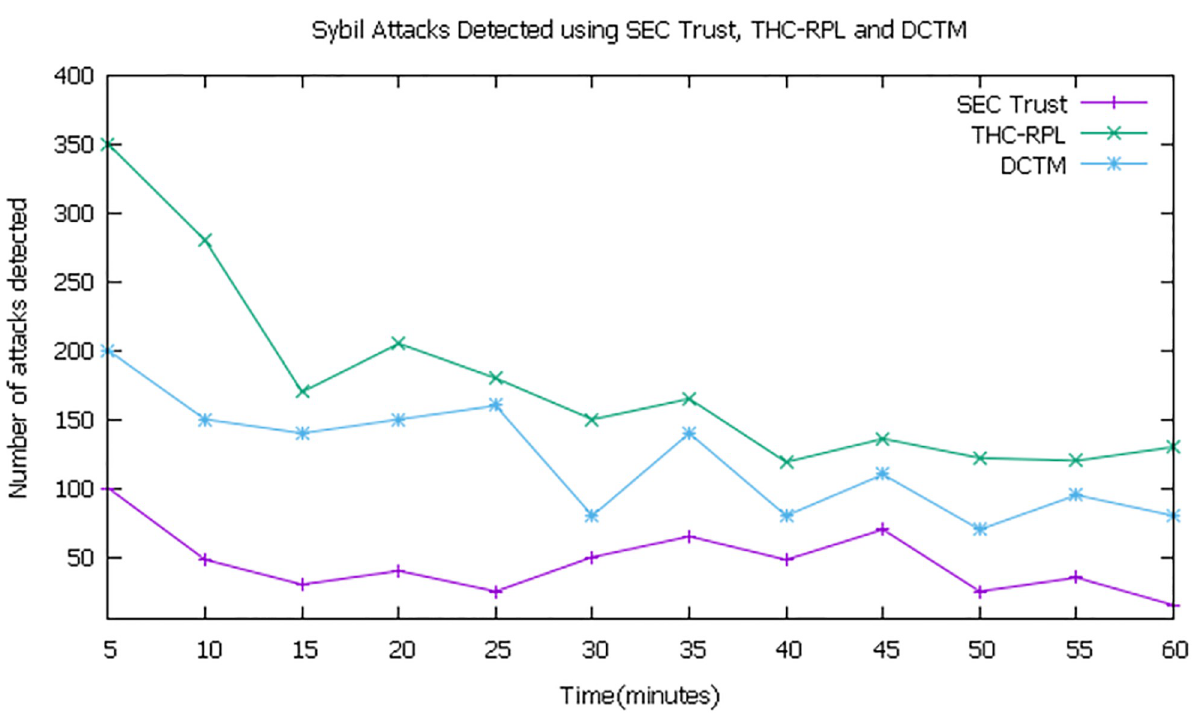
Fig 4. The non-storing and storing modes of